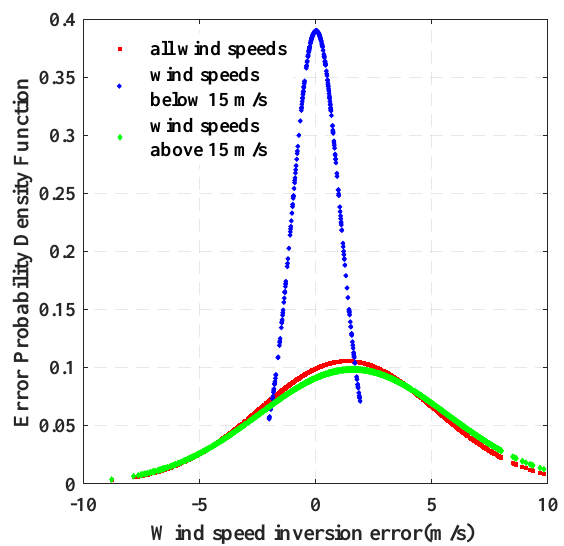
Figure 4. Probability density function of wind speed inversion errors.